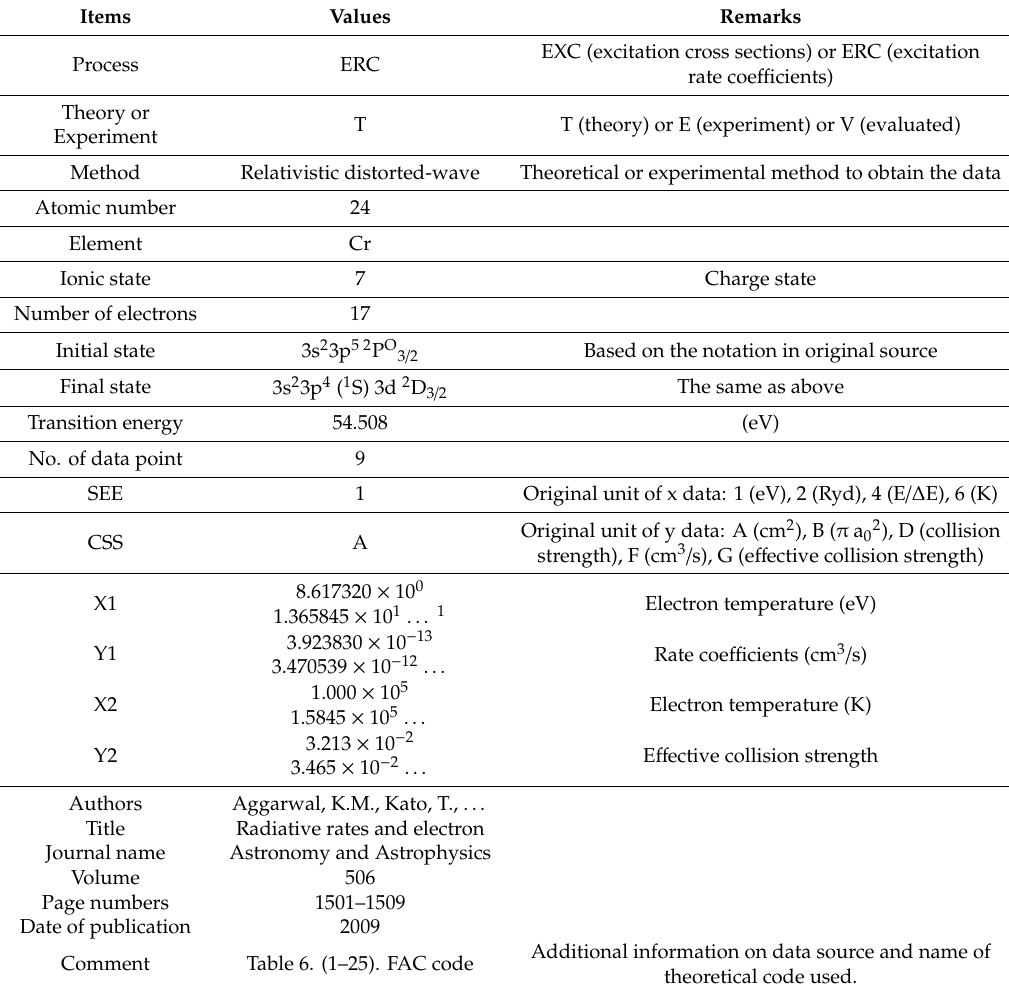
Table 2. An example of one data record stored in AMDIS EXC.